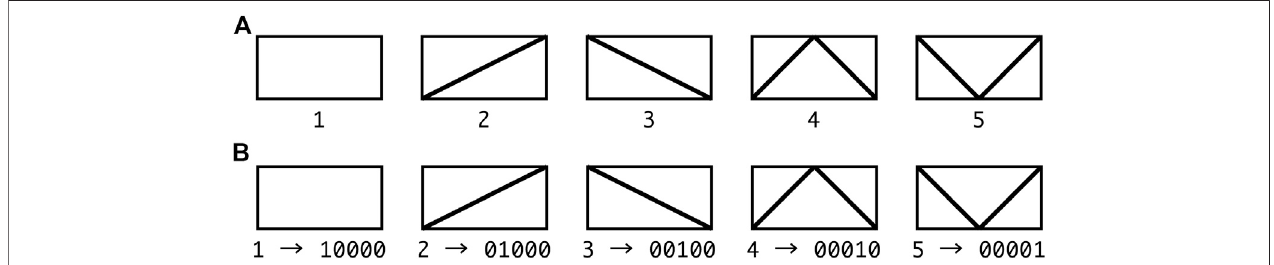
FIGURE 2 | Types of braces including “ no-brace ” ; (A) categorical variable, 1) no-brace, 2) right diagonal brace, 3) left diagonal brace, 4) K-brace, 5) V-brace, (B) binary representation of brace types.